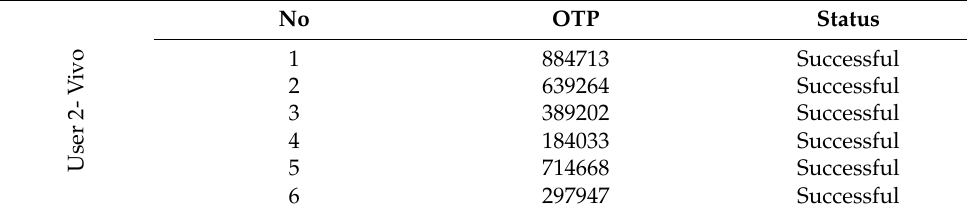
Table 4. The OTP results of the Vivo user.